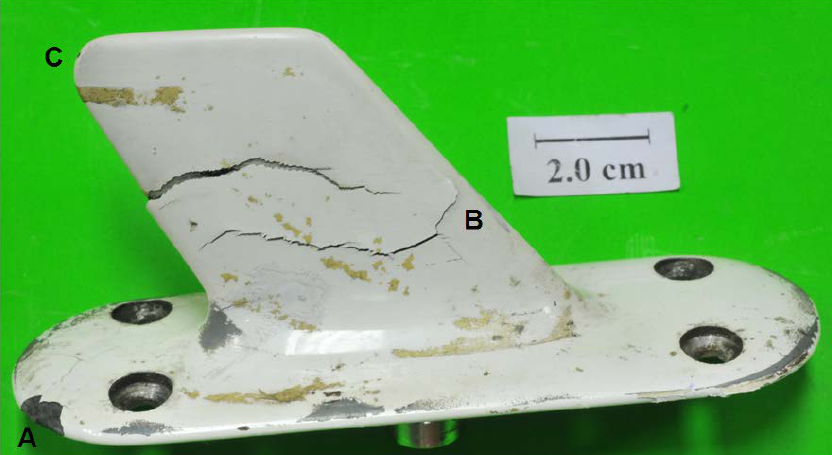
Figure 3: The photograph of the damaged antenna in as-received